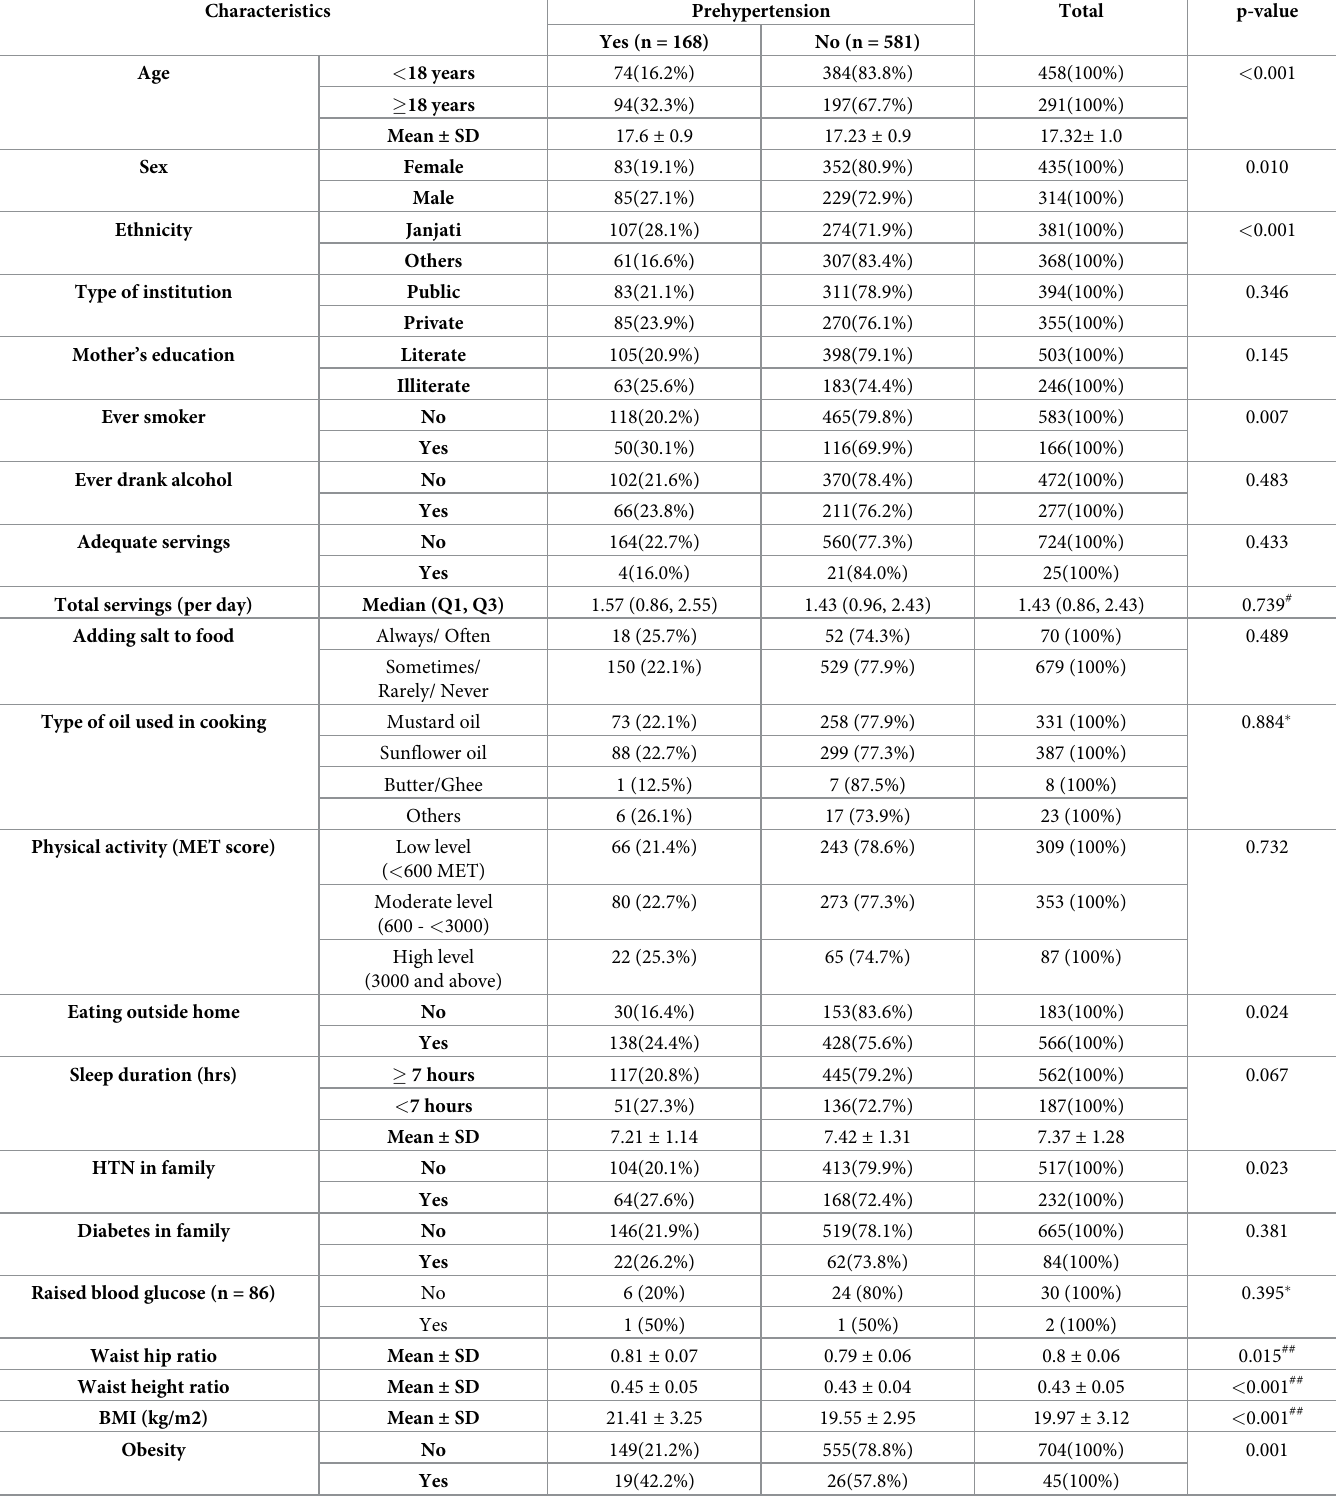
Table 3. Socio-demographic characteristics and biophysical measurements of participants by pre-hypertension status (n =